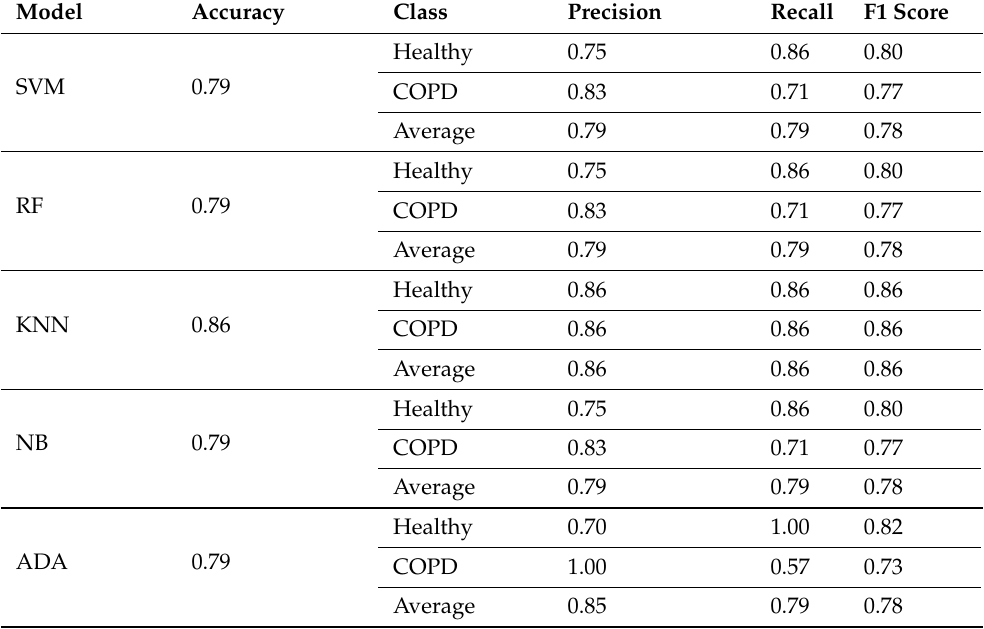
Table 3. Performance of machine-learning models for COPD classification.